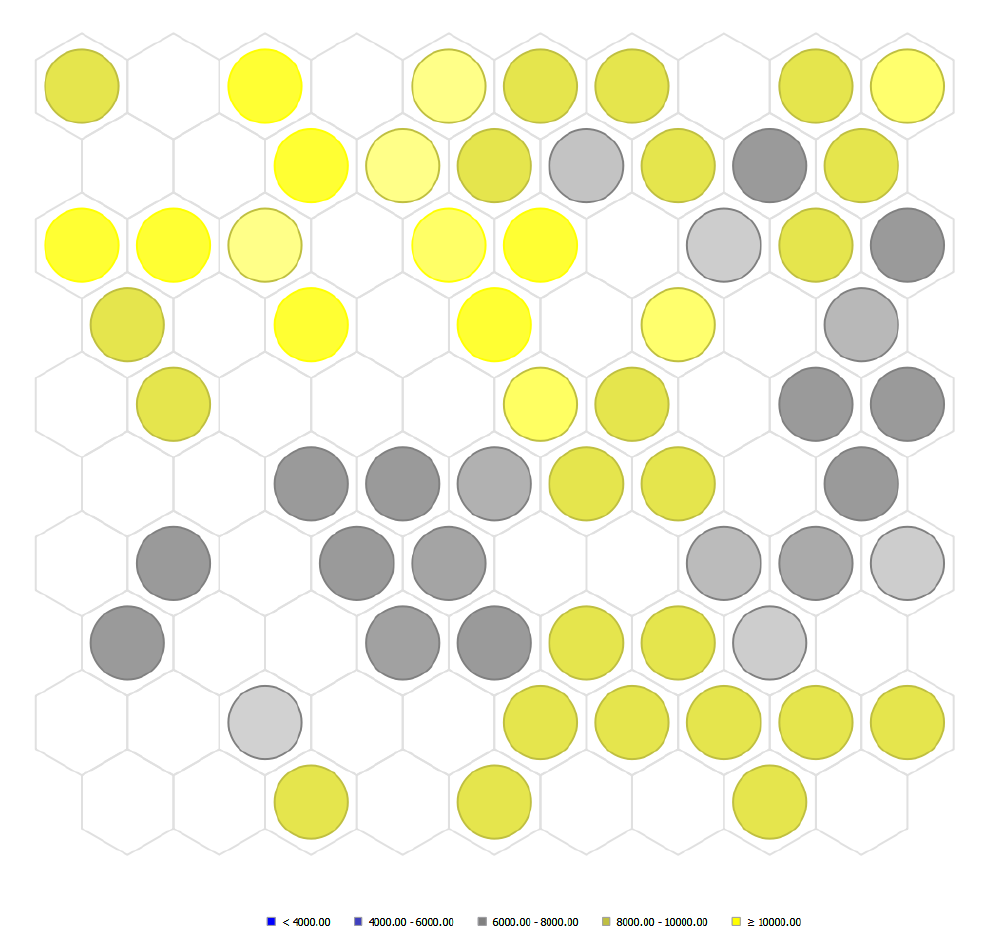
Figure 6. Self-organizing Map of Bitcoin spot with the rest of the database. Note: A self-organizing map is an unsupervised learning algorithm that infers low, typically a two-dimensional discretized representation of the input space called a map. The map preserves the topological properties of the input space. The data are ranked according to Table 1. In yellow color, the variables share similar characteristics with the Bitcoin spot (mostly cryptos). In grey color, the variables appear to share lower characteristics with Bitcoin. Against the white background, the variables appear to exhibit no relationship with